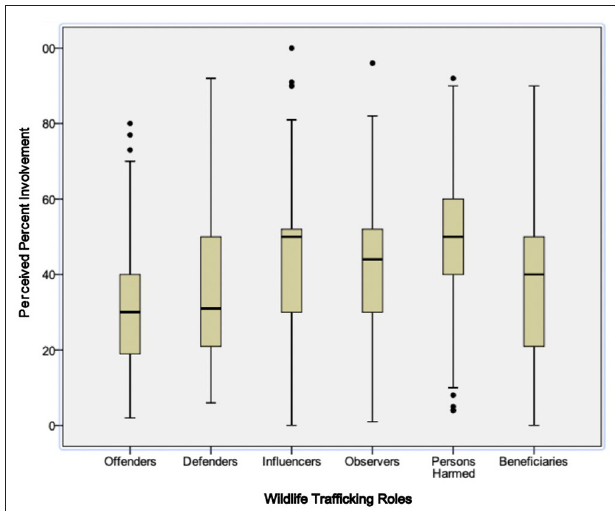
FIGURE 1 | Bar and whisker plot illustrating variation in experts’ perceptions ( n = 215) about women’s involvement in six different primary roles for women in wildlife trafficking (February 2020). Points outside the whiskers indicate outliers, defined as cases falling more than 1.5 box lengths from the lower or upper hinge of the